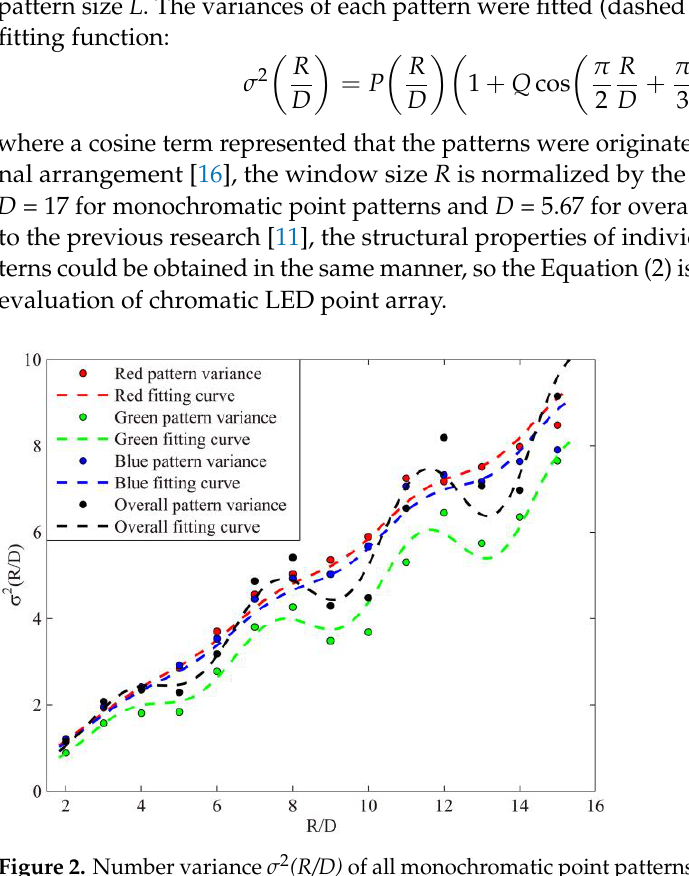
Figure 2. Number variance σ 2 (R/D) of all monochromatic point patterns and the overall point pattern, and their corresponding fitting curves. Table 1. Fitting coefficients for different types of point patterns.